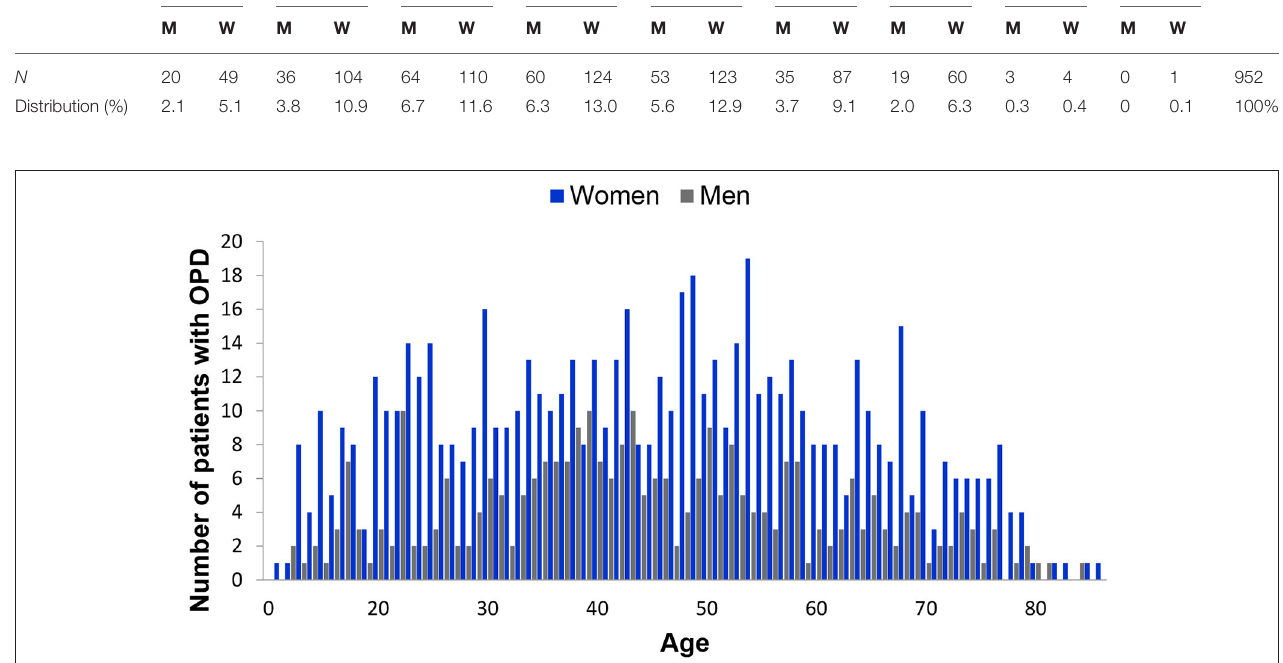
FIGURE 1 | Age and gender distribution of the global sample of 952 patients experiencing orofacial pain and dysfunction